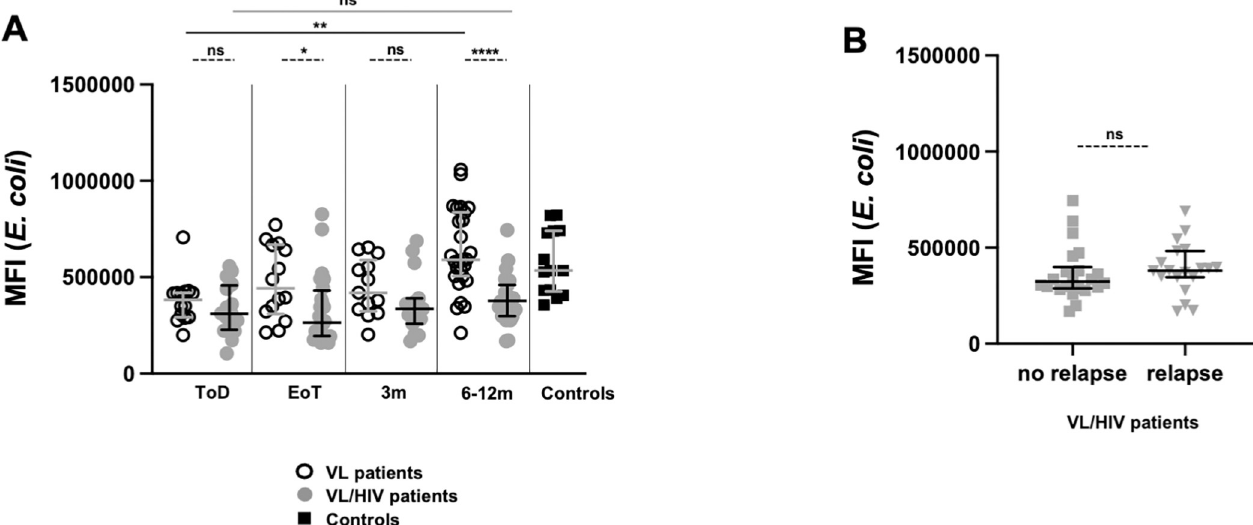
Fig 5. Comparison of bioparticle phagocytosis between VL and VL/HIV patients and controls over time. Neutrophils were isolated by dextran sedimentation from the blood of controls (n = 15), VL (ToD: n = 14, EoT: n = 14, 3m: n = 13, 6-12m: n = 27) and VL/HIV (ToD: n = 16, EoT: n = 24, 3m: n = 15, 6-12m: n = 26) patient and the MFI of E . coli particles were measured by flow cytometry, as described in Materials and Methods. Each symbol represents the value for one individual. A. Comparison of bioparticle phagocytosis by neutrophils from VL, VL/HIV and controls patients over time. B . Comparison of bioparticle phagocytosis by neutrophils from VL/HIV patients who did not relapse (n = 22) and those who relapsed (n = 19) after successful anti-leishmanial treatment, during the 3m and 6–12 follow-up period. If a patient did not relapse during the two-time points of follow-up and if a patient relapsed at both 3 and 6–12 months, this is represented as 2 measurements. Results are presented as median with interquartile range. Statistical differences between VL and VL/HIV patients at each time point or between VL/HIV patients who did not relapse and those who relapsed were determined using a Mann- Whitney test and statistical differences between the 4 different time points for each cohort of patients were determined by Kruskal-Wallis test. ToD = Time of Diagnosis; EoT = End of Treatment; 3m = 3 months post EoT; 6-12m = 6–12 months post EoT. ns = not significant.